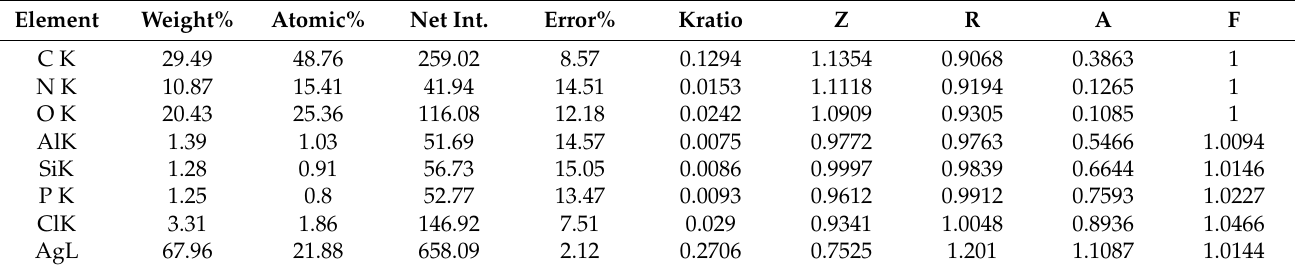
Table 2. Elemental analysis of AgNPs synthesized from Elaeagnus umbellata fruit extract.